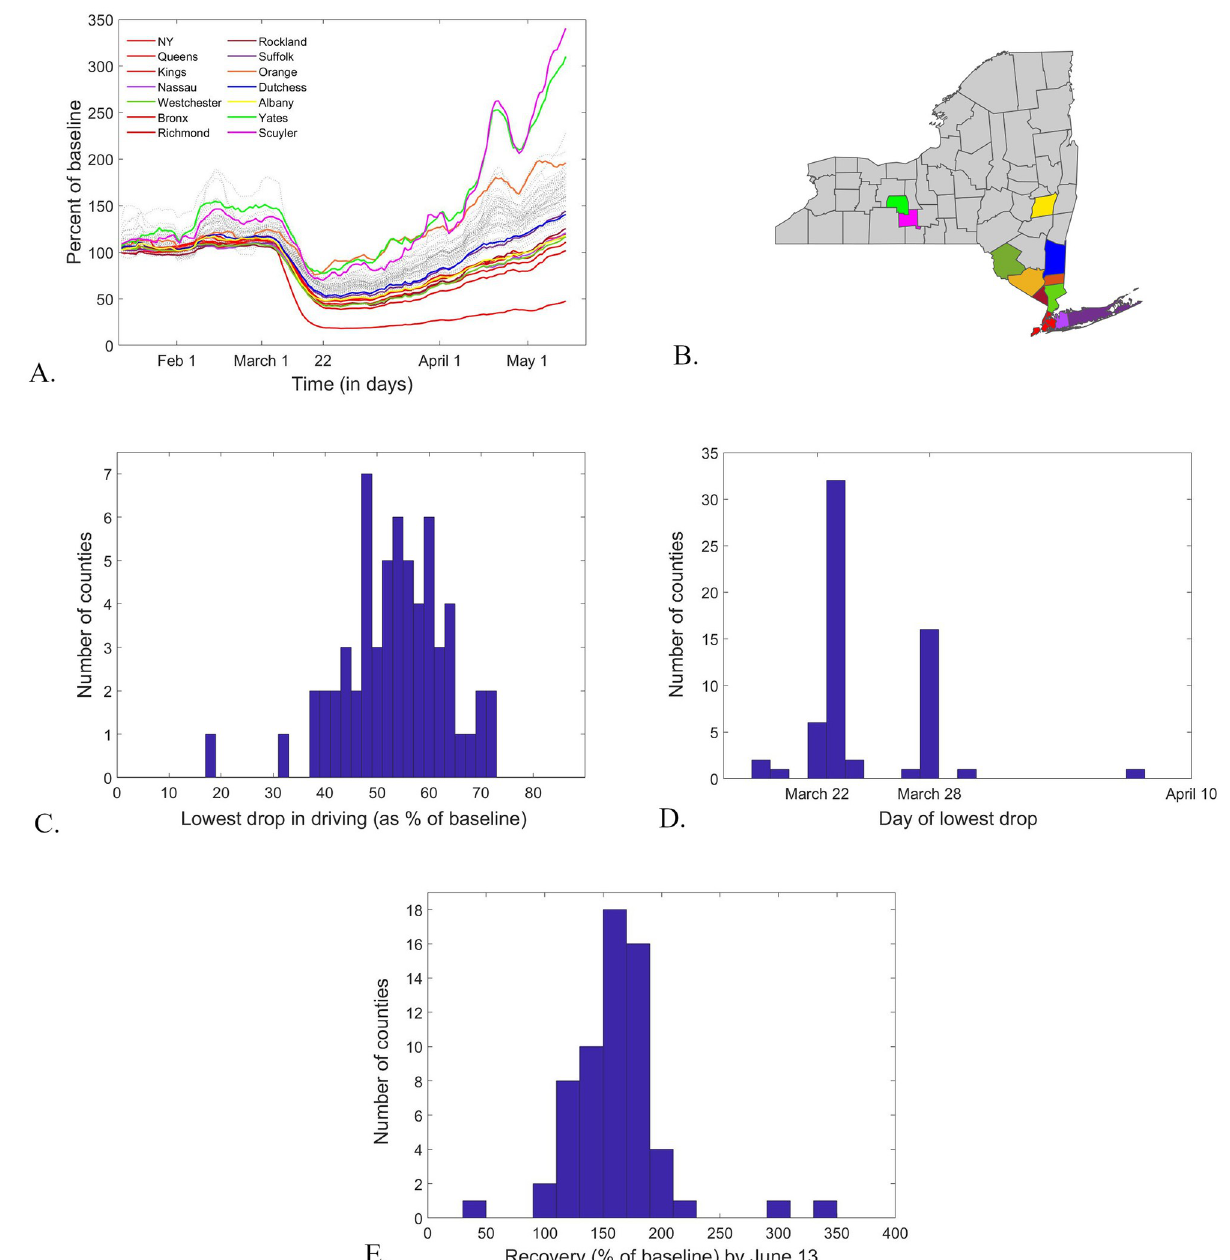
Fig 4. Description of driving trends (as per the Apple data set) in New York counties. A. Time course (of numbers of hits to driving destinations per day with respect to baseline). Each curve shows the timeline for one county: the counties with high infection rates are color coded and shown in the legend; the others are shown as dotted grey lines . B. The location of each county shown in color in panel A is represented in the same color on the NYS map . C. Histogram of the lowest driving levels, as fraction of baseline . D. Histogram of the day in the time course when the lowest driving level (shown in C) occurred for each county . E. Histogram of the comeback driving level for each county, as of the last day computed by our smooth window averaging (June 13) . most pronounced drop in all of the five cases, but the level of this drop and the subsequent upturn slope still differ between counties (with New York City showing, unsurprisingly, the most pronounced drop from a very high baseline of public transit, and also showing the slow- est comeback (to less than 40% baseline by June 20). The most pronounced differences across